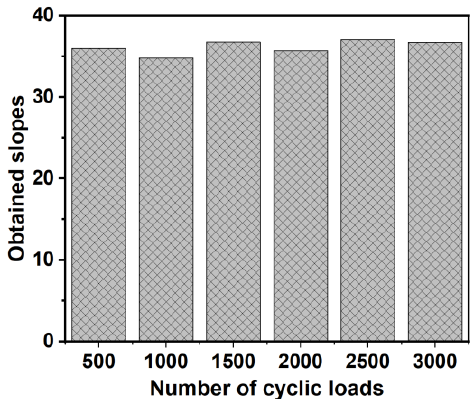
Figure 10. The slops of linearly fitting lines for the voltage-displacement curves after sustaining different numbers of cyclic loads.